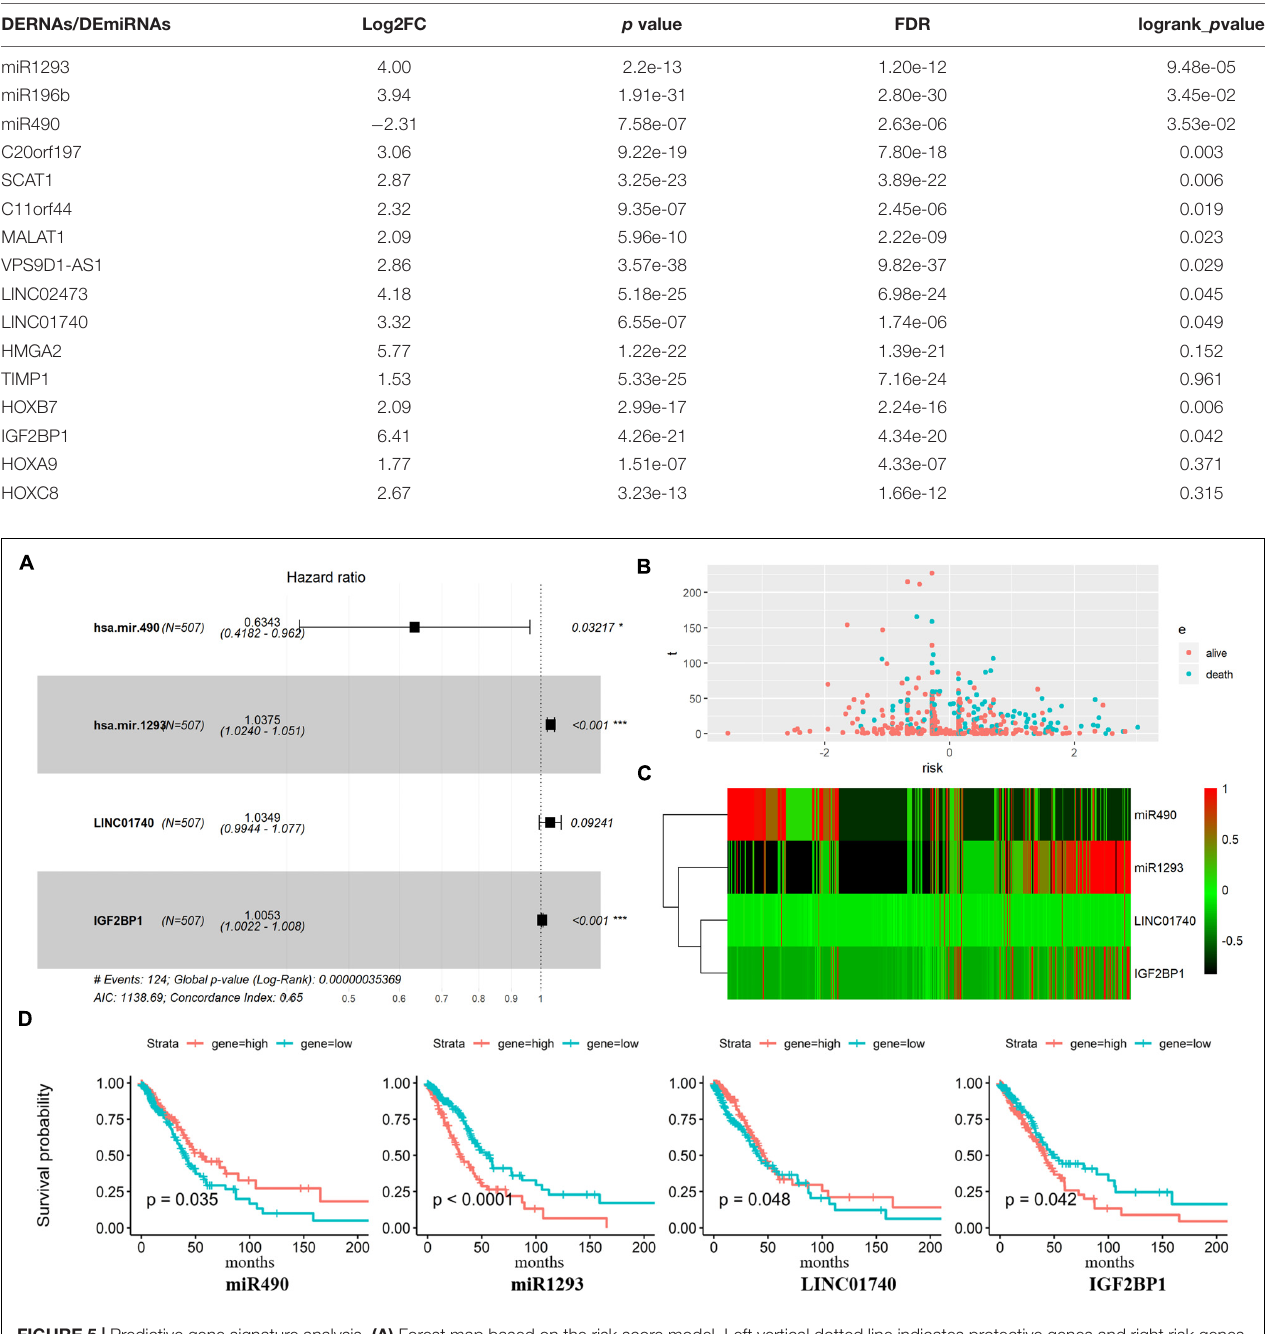
TABLE 4 | Information about differentially expressed RNAs and miRNAs in ceRNA network. DERNAs/DEmiRNAs Log2FC p value FDR